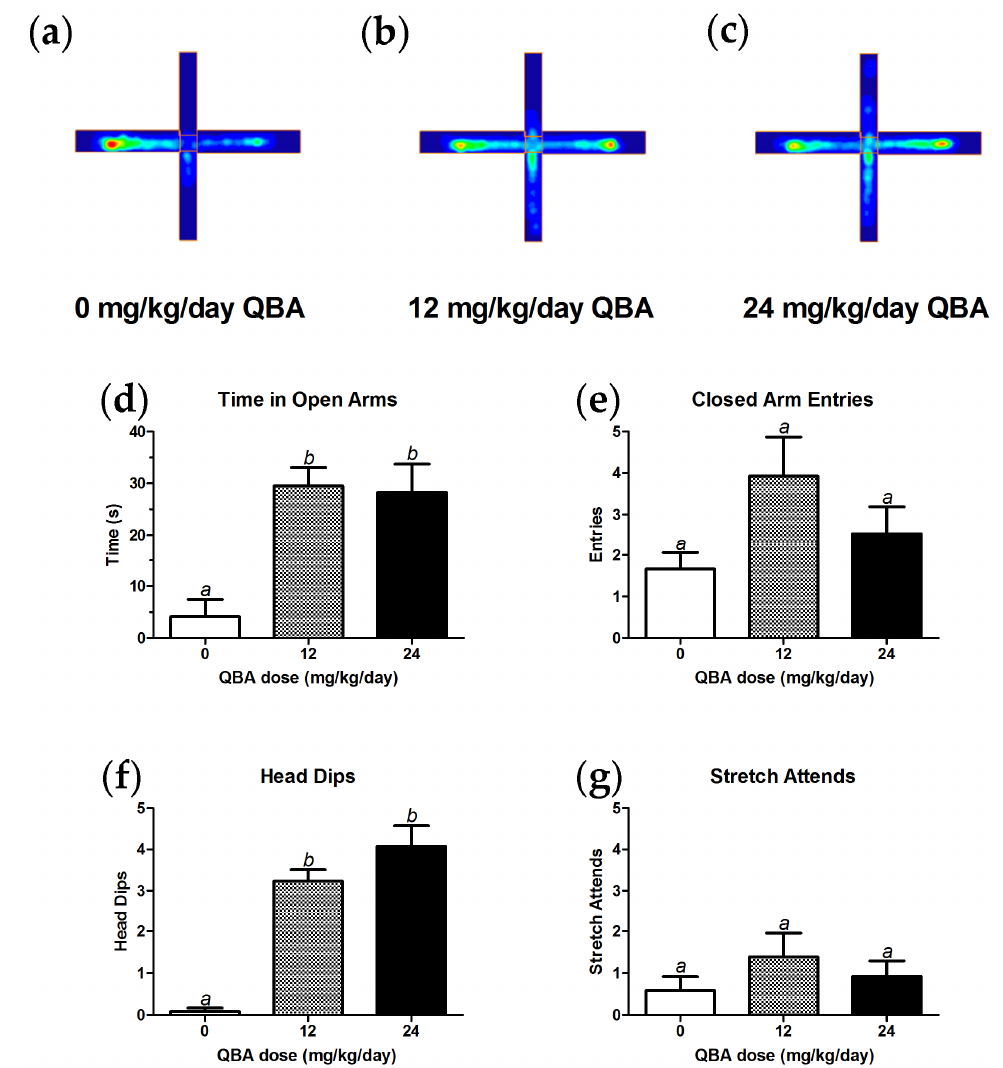
Figure 3. QBA decreased anxiety in aged male rats. Qualitative, positional heatmaps show the average time spent in the open arms (vertical axis) and closed arms (horizontal axis) of the elevated plus maze for ( a ) controls, ( b ) animals given 12 mg/kg/day QBA and ( c ) animals given 24 mg/kg/day QBA (blue = low amount of time; yellow = intermediate; red = high amount of time). Quantitation and analysis of the plus-maze behaviors indicated that QBA increased the amount of time spent in the open arm ( d ), had no effect on the number of closed arm entries ( e ), increased the number of head dips ( f ), and did not affect stretch-attend behavior ( g ). Lack of shared superscripts indicates groups that differed significantly ( p < 0.05) in Tukey’s post hoc test. N = 12–13 for each experimental arm. Error bars represent the SEM.